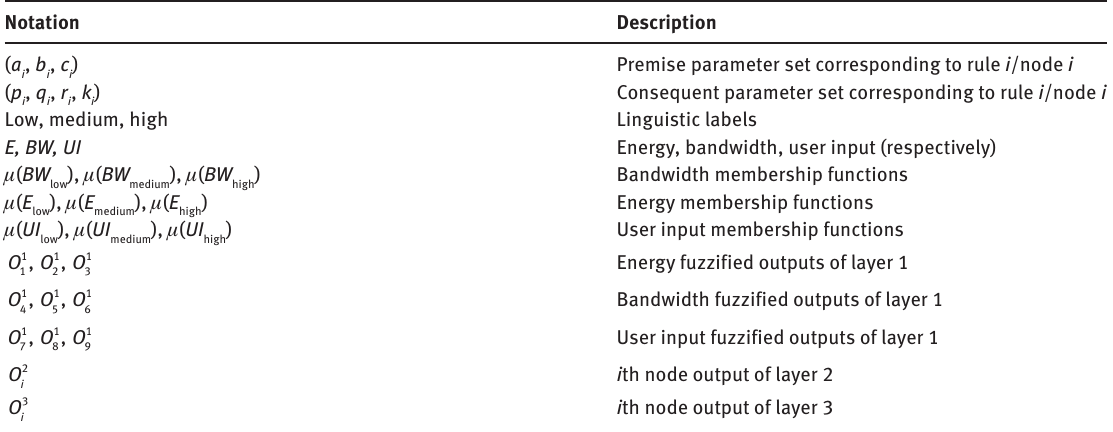
Table 5: Parameters and Notations used in